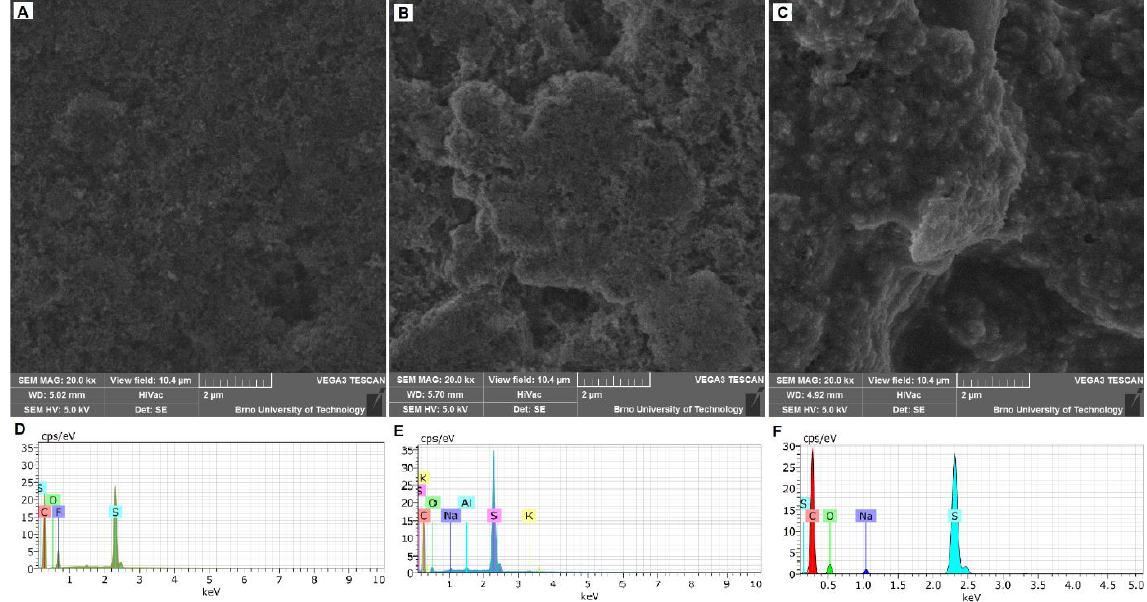
Figure 1. SEM images (field of view 10.4 µ m) and EDS spectra of the electrode surface: ( A ) S-PVDF electrode surface, ( B ) S-Car-Iota electrode surface, ( C ) S-Car-Lamb electrode surface ( D ) S-PVDF EDS spectra, ( E ) S-Car-Iota EDS spectra, ( F ) S-Car-Lamb EDS